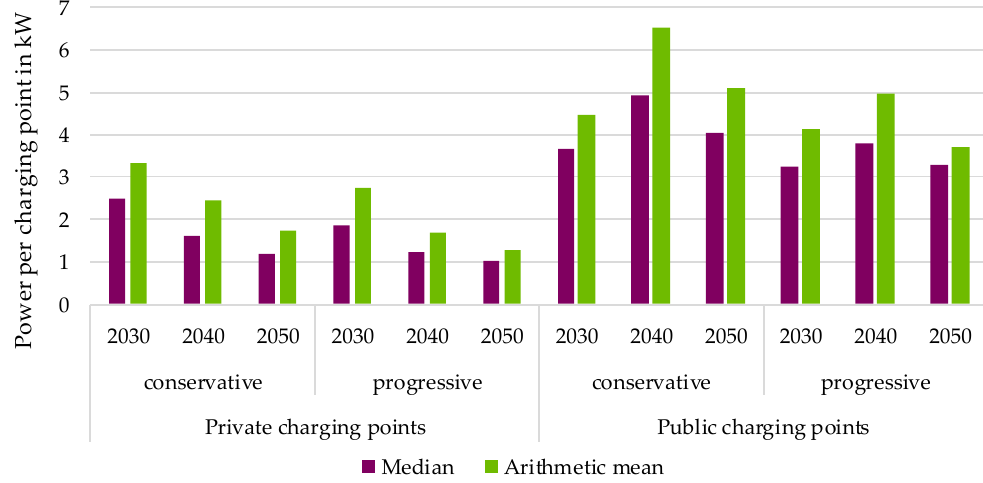
Figure 13. Effective charging power per charging point for private and public charging points for dimensioning the outgoing feeders for the different years and the two scenarios.